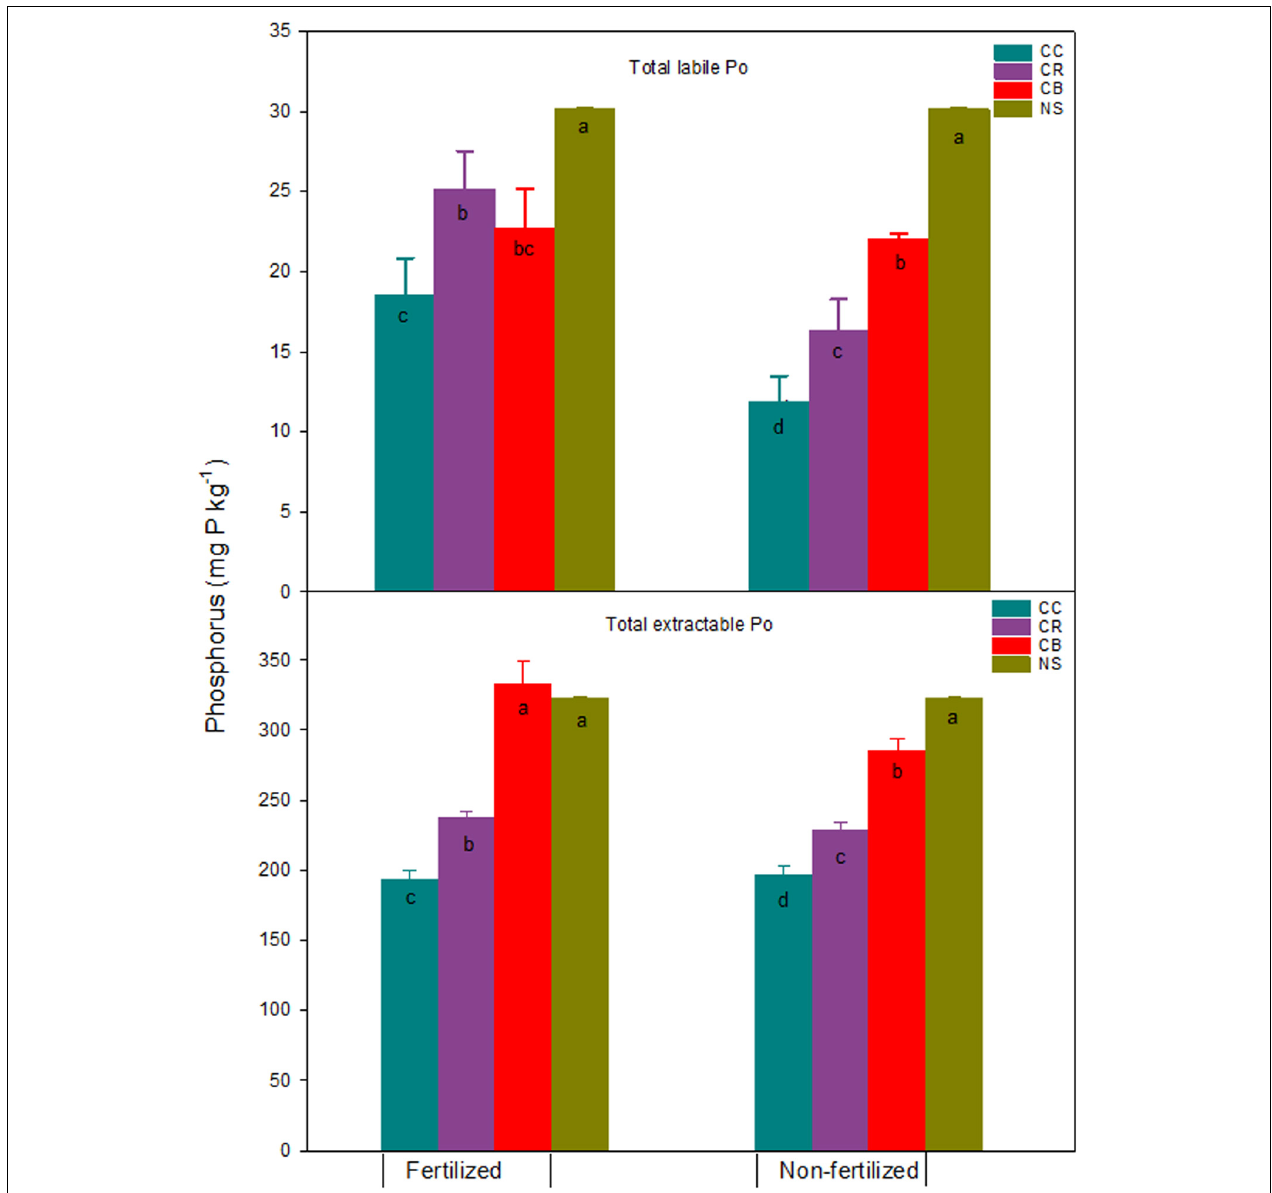
FIGURE 5 | Total extractable P o and labile P o and standard errors ( n = 3) (mg kg − 1 ) in a Brookston clay loam at Woodslee, ON, Canada, after 45-year consistent cropping with and without P fertilization relative to its native forest soil (NS). CC, continuous corn; CB, continuous bluegrass sod; CR, corn-oats-alfalfa-alfalfa rotation. Letters in the bars are significant levels (at P ≤ 0.05) with LSD test conducted separately for the fertilized and non-fertilized